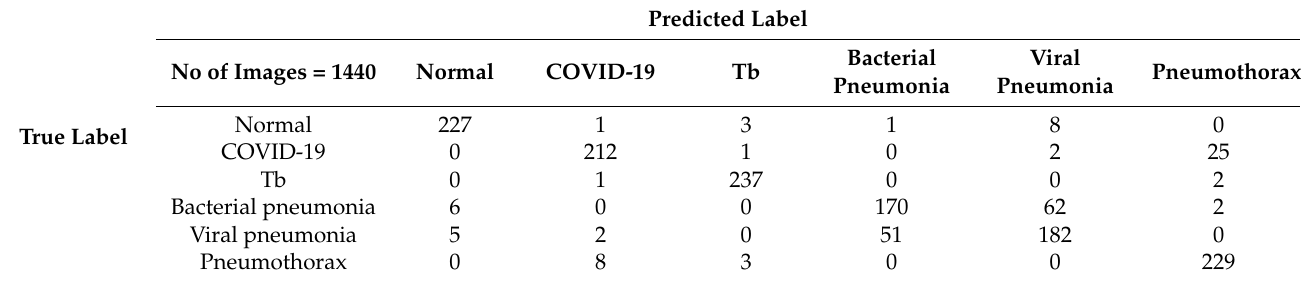
Table 12. Validation confusion matrix of DenseNet201 for six-class classifier.